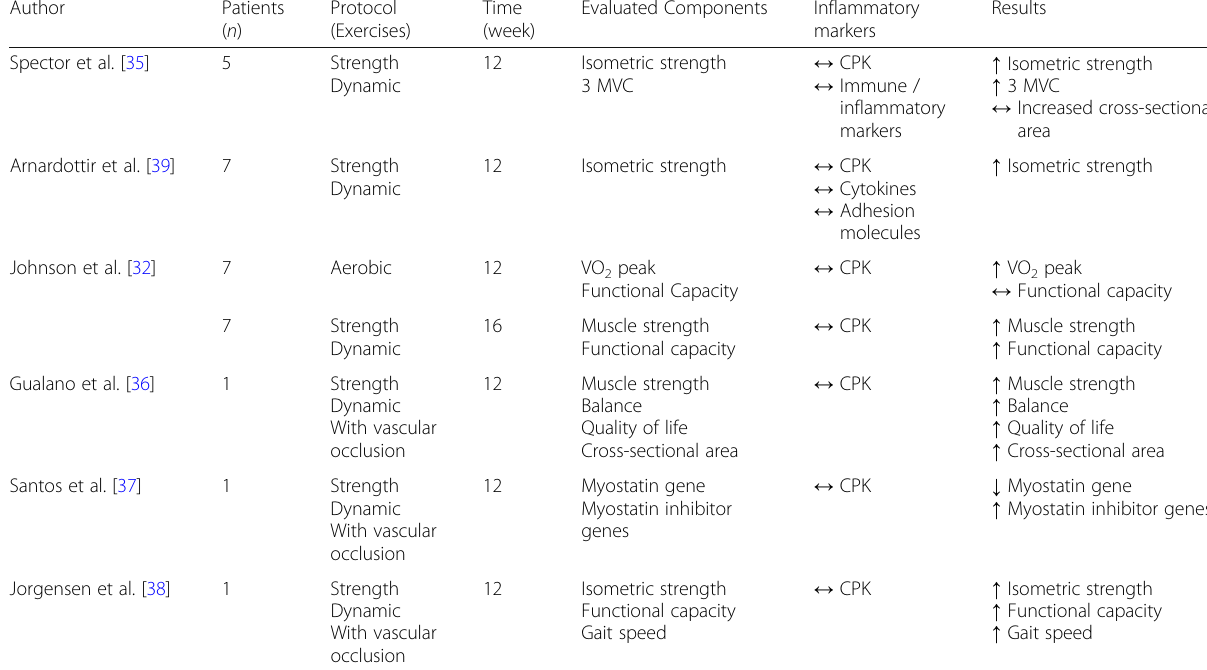
Table 4 Physical exercise in patients with chronic inclusion body myositis